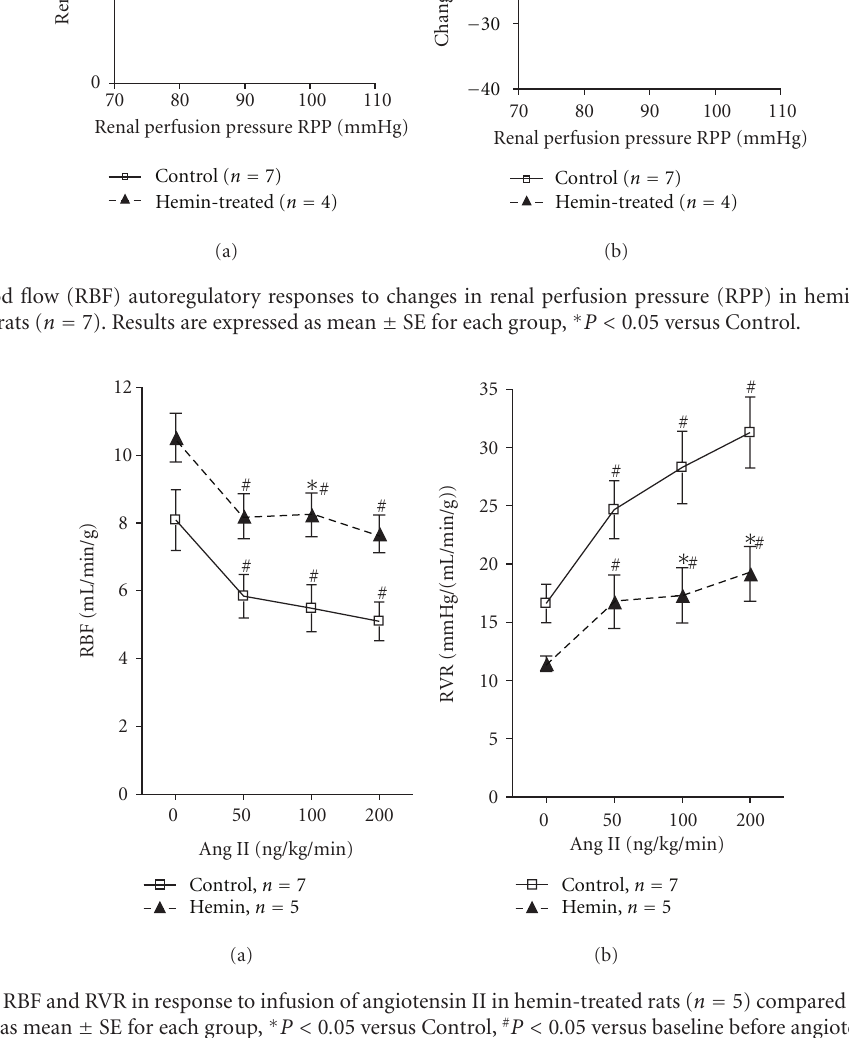
Alteration in Mean Arterial Pressure or Heart Rate. HR